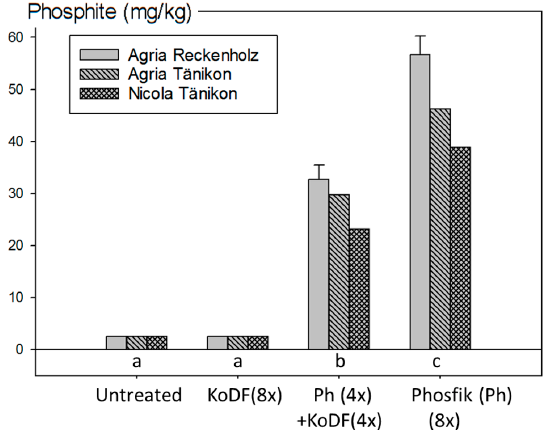
Figure 5. Residues of phosphite (PO 33 − ) in untreated and treated potato tubers from the field experiments in 2012. Tubers of the following treatments were analysed: Kocide DF (KoDF) alone (eight applications), Phosfik ® (Ph) (four applications of 3 L/ha) followed by KoDF (four applications) or Phosfik ® (Ph) alone (eight applications with 3 L/ha) (Table S4). Samples were taken at Reckenholz from Agria and at Tänikon from Agria and Nicola. Bars represent the mean values of the varieties and standard errors of the means. For “Untreated” and “KoDF(8×)”, concentrations were below the limit of detection (LOD = 5 mg/kg) and half of the LOD was plotted. Treatments labelled with the same letter are statistically not different (Tukey test p < 0.05).